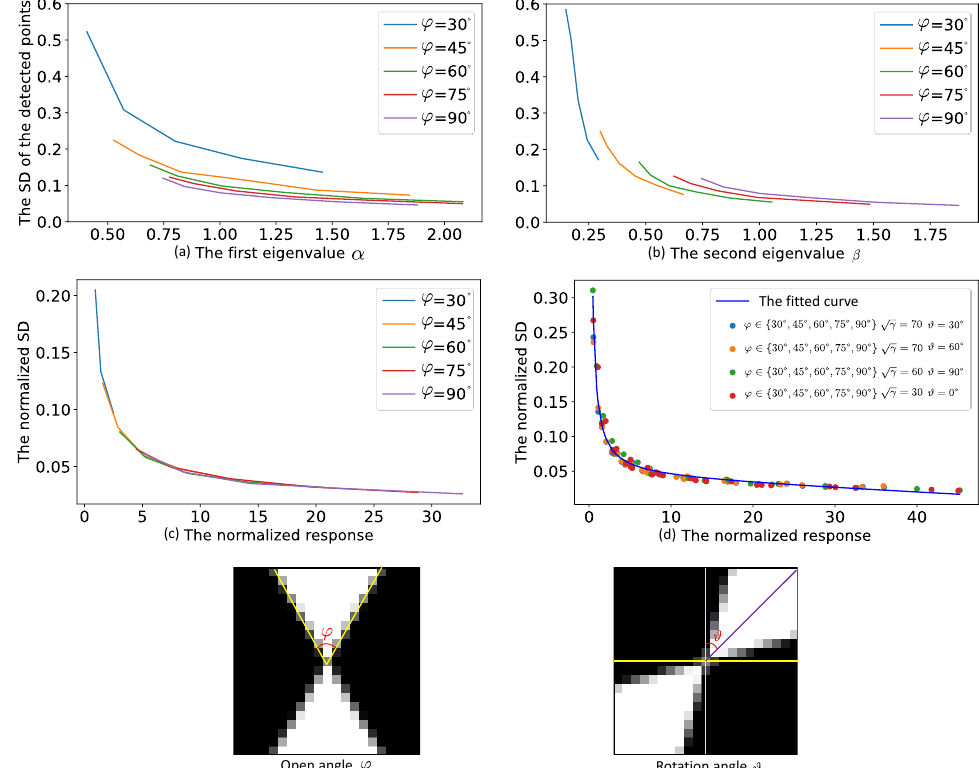
Figure 2. ( a , b ) illustrate the changes in the standard deviations of the control points with regard to the increase in the eigenvalues of the autocorrelation matrix of the control points at five open angles. The same eigenvalue corresponds to different standard deviations at different open angles. The two points at the bottom of the figure represent the open angle ϕ and the rotation angle ϑ . ( c ) shows the changes in the normalized standard deviations of the control points with regard to the increase in the normalized point response at five different open angles. ( d ) illustrates the fitted curve for the relationship between the normalized responses and the normalized standard deviations at different open angles ( ϕ ), rotation angles ( ϑ ) and SNRs ( γ